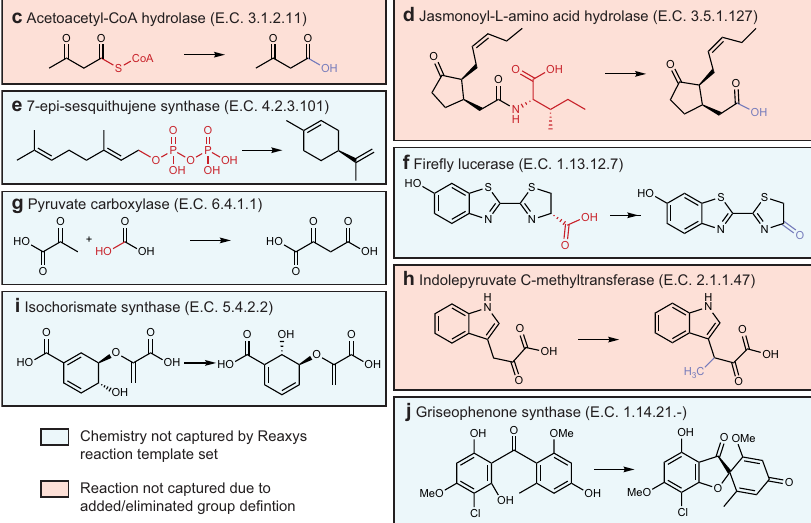
Fig. 3 | Comparison of synthetic and enzymatic reaction sets. Most commonly, a eliminated and b added substructures in reactions from the BKMS dataset that werenotcapturedbytheReaxysdatasetreactiontemplates. c – j Reactionsfromthe BKMS dataset that were not recovered by applying any of the Reaxys dataset reaction templates to the product molecules. Reactions where the underlying